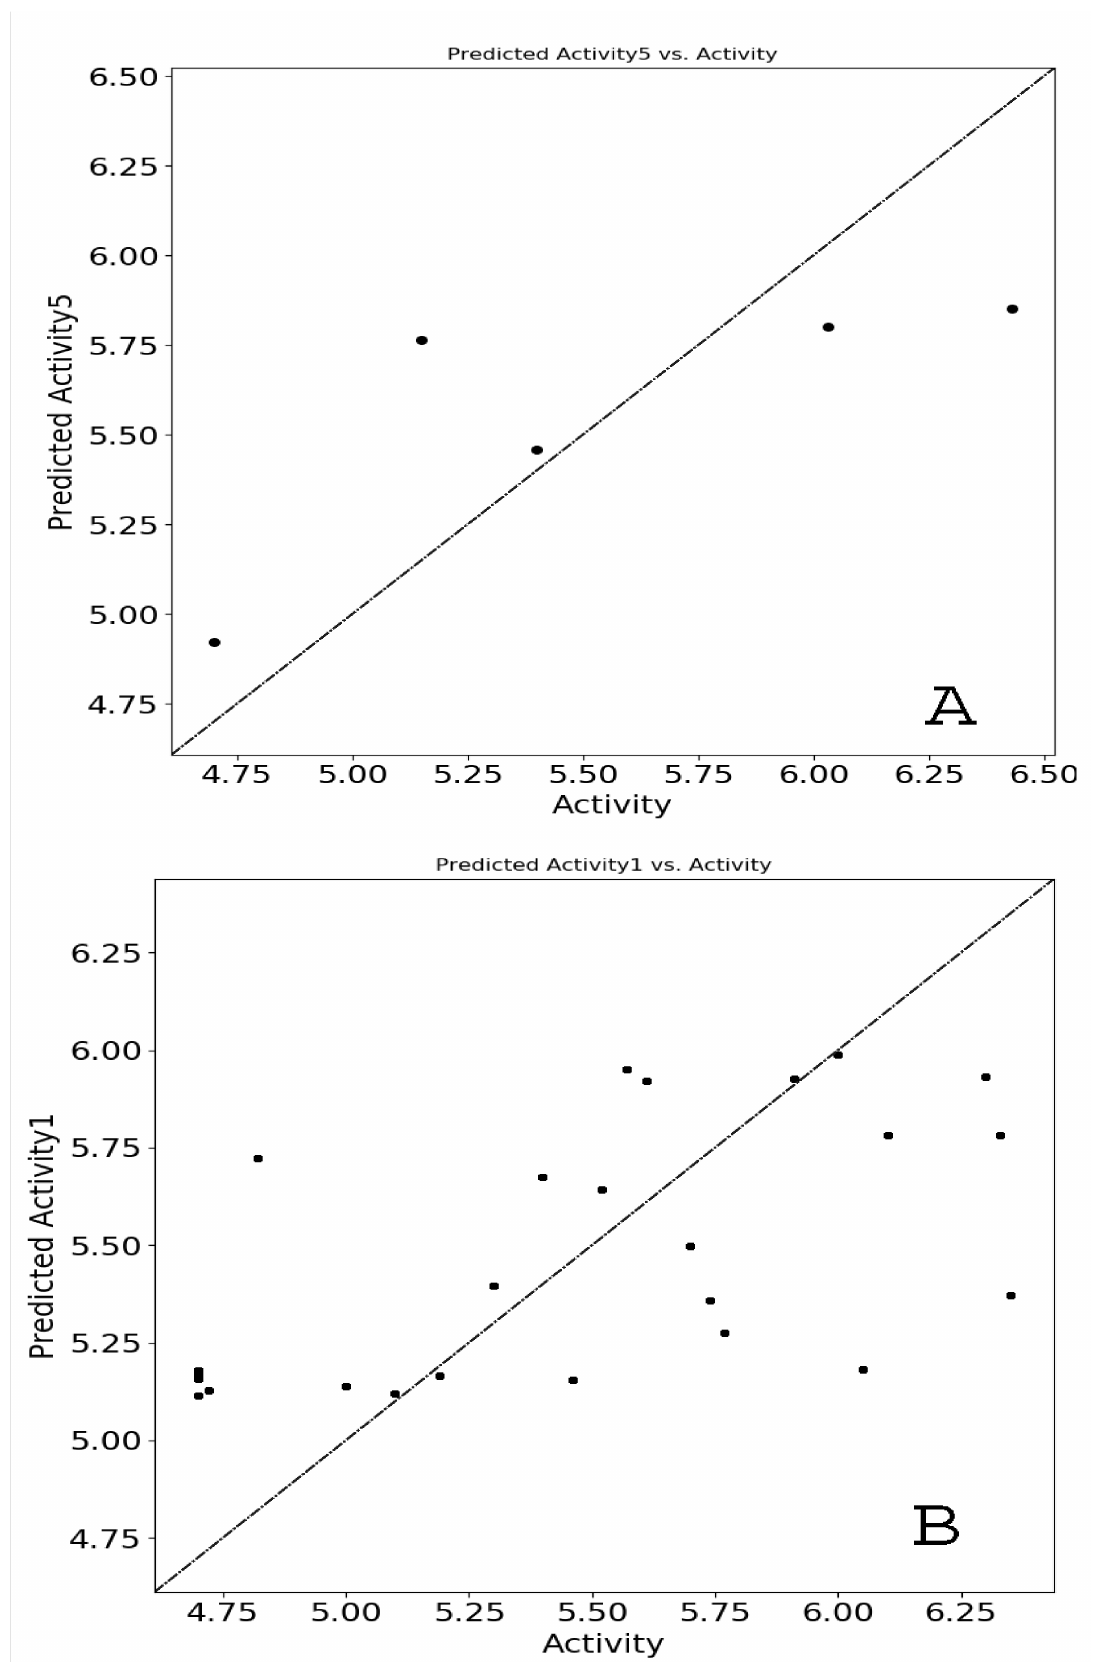
Figure 6. Comparison between actual vs. predicted pIC 50 values of ( A ). test and ( B ). a training set molecules,